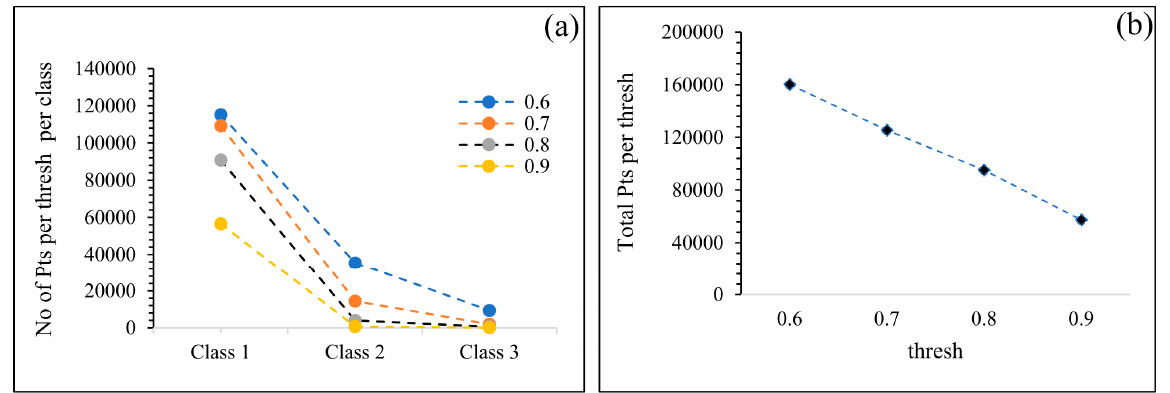
Figure 9. The plot of the number of PSs per threshold per class (a) and the total number of PSs per threshold (b).